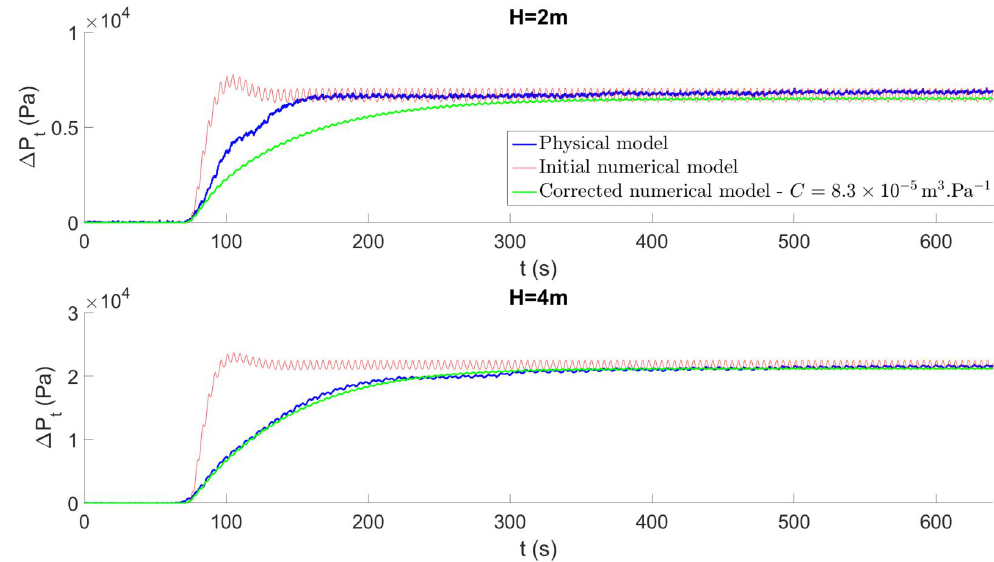
Figure 11. Pressure drop time series across Orifice 3 of the Tupperwave device obtained by the physical model, the initial numerical model, and the corrected model in the regular waves of a 9-s period and heights of 2m and 4m.